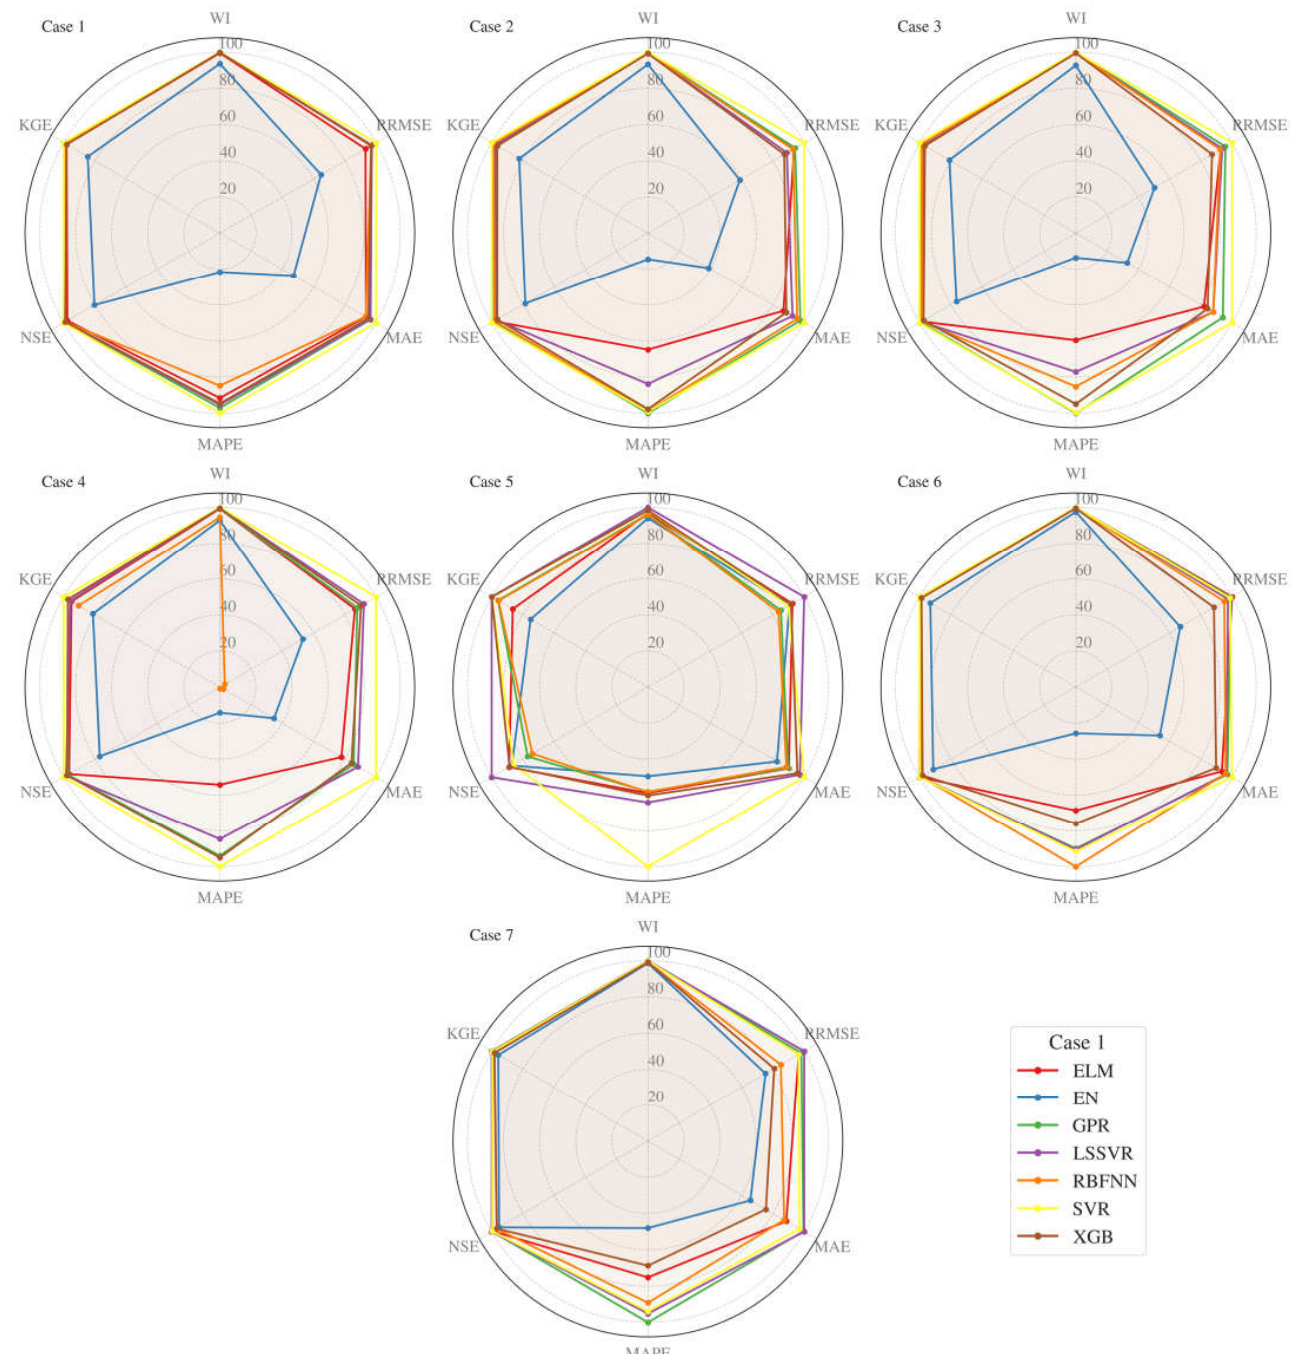
Figure 6. Radar charts for all metrics (averaged over 50 runs). The uncertainty analysis allows for comparing the proposed models and the input cases in this study. Table 14 presents a quantitative evaluation of uncertainties in river flow forecasting for each machine learning model and each input case to see the effects of the uncertainty study, the models’ mean prediction errors, the width of the uncertainty band, and the 95% prediction interval error. Negative mean prediction error averages indicate that the prediction models underestimated the observed values. On the other hand, positive values indicate that they overestimated the outcomes. Smaller mean predicted errors represent the ability to model the streamflow. The SVR model leads to